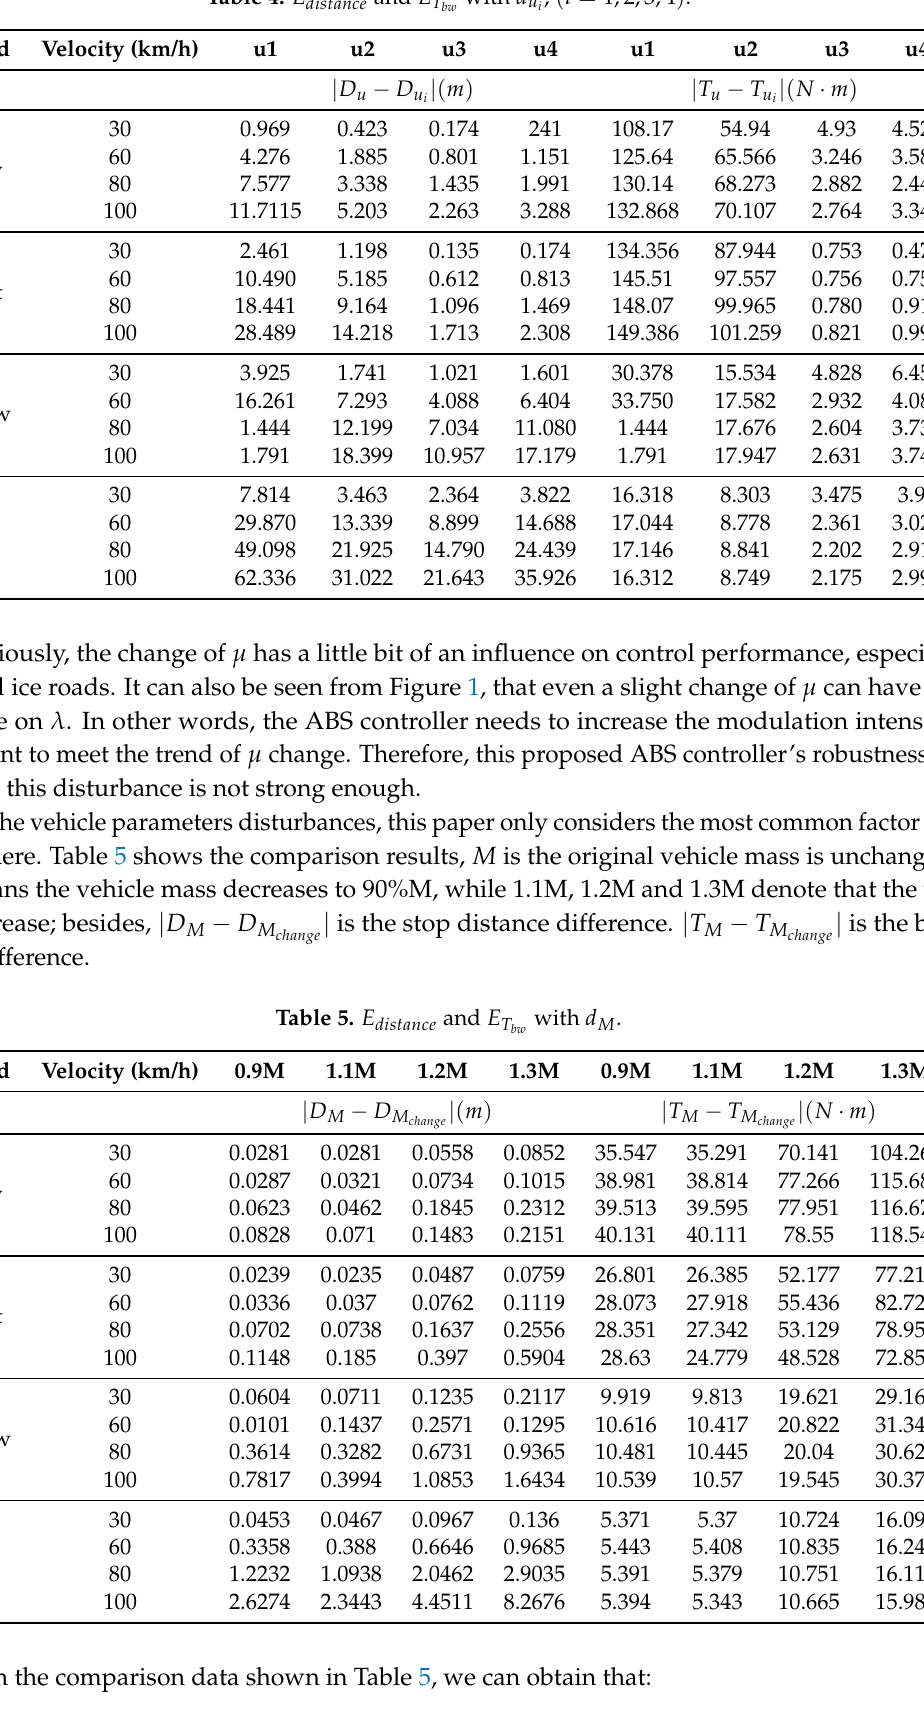
Table 4. E distance and E T